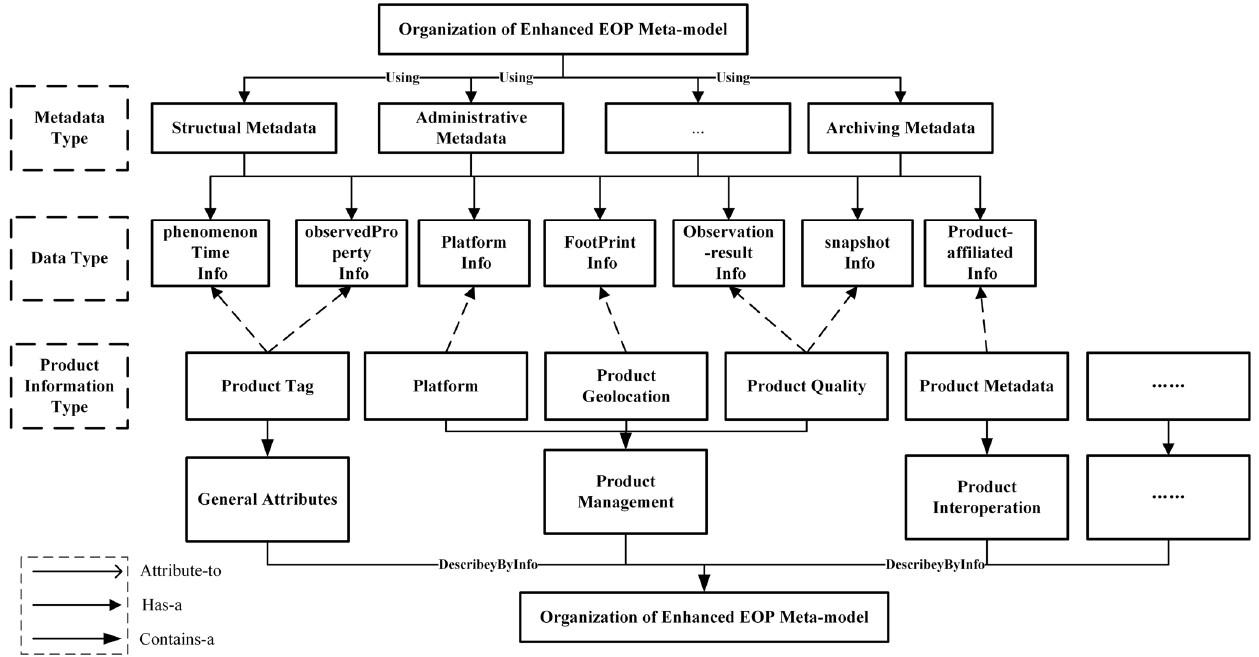
Figure 3. Enhanced EOP meta-model